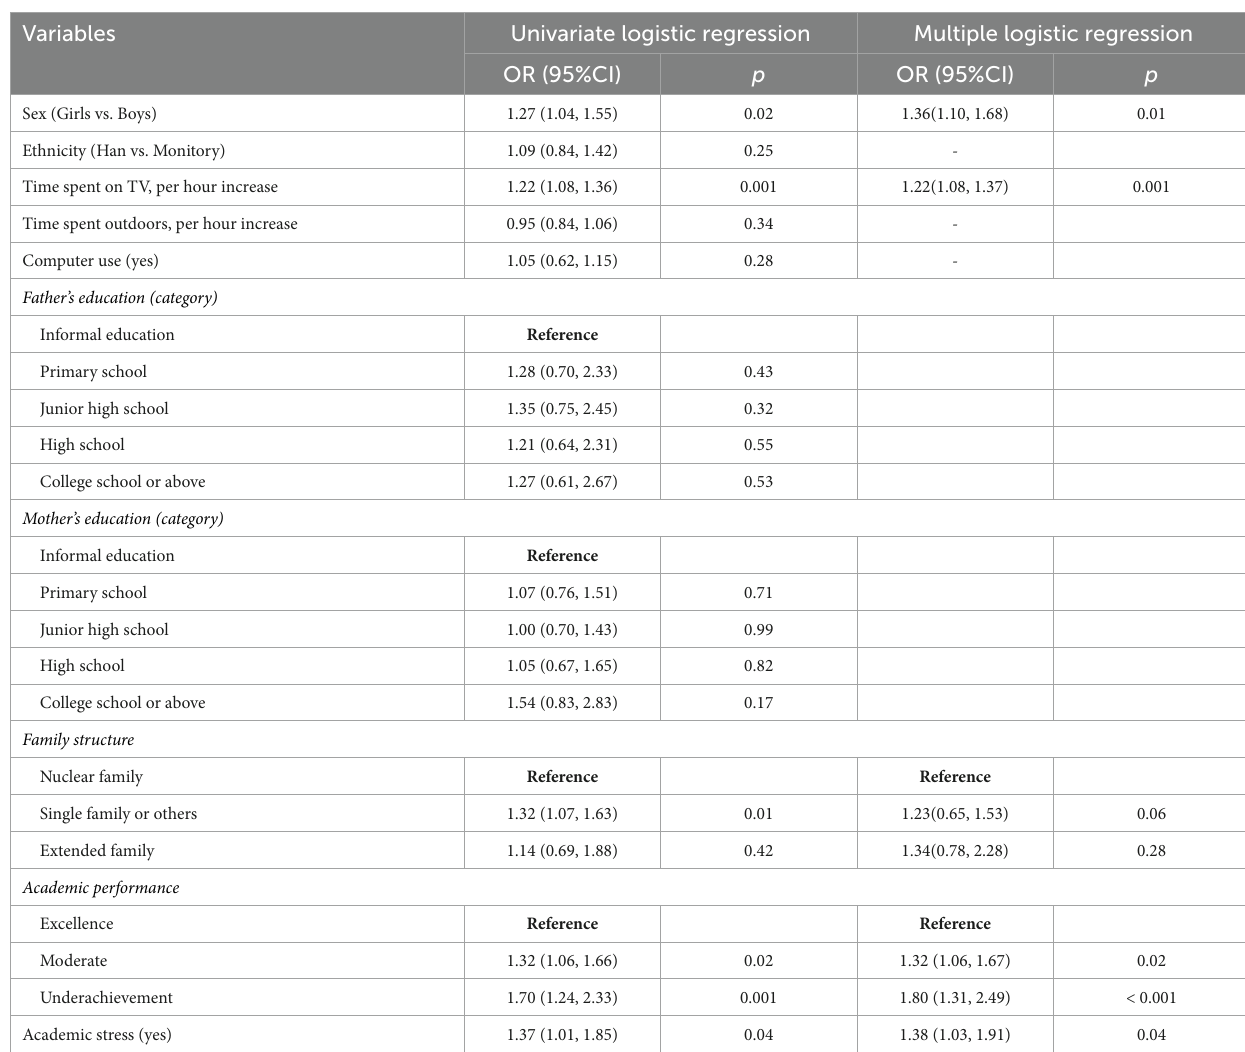
TABLE 4 Logistic regression model of factors associated with sleep disorders ( N =